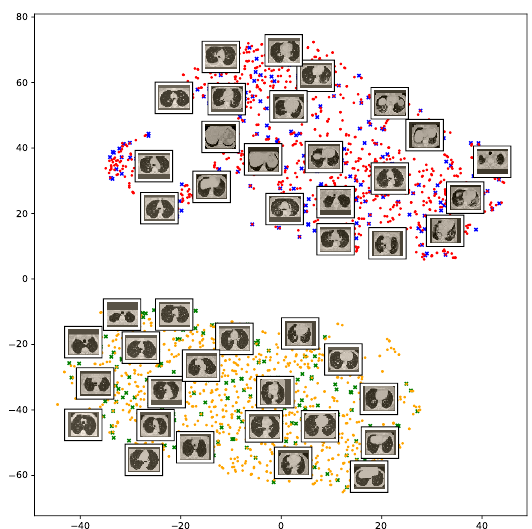
Figure 11. Visualization of the t-SNE embeddings for the entire SARS-CoV-2 CT dataset. We clearly see two different clusters representing COVID-19 (red for training and blue for test samples) and non-COVID-19 (yellow for train and green for test samples)